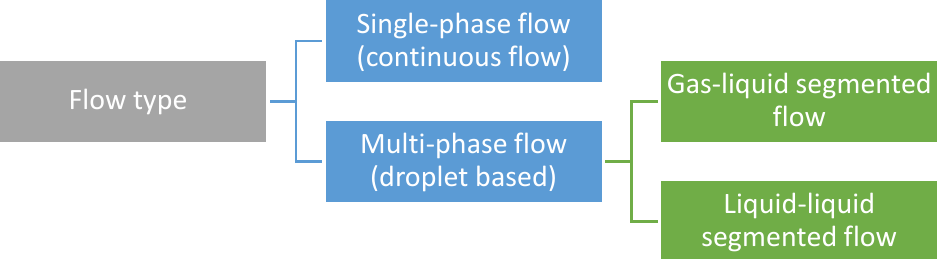
Figure 2. Microfluidic techniques classification. Created based on information from the literature [11,16,83].